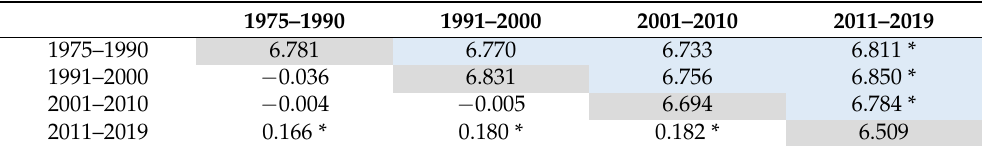
Table 3. Average pairwise differences between each generation interval period in the total population (related and unrelated horses). Above the diagonal (blue): average number of pairwise differences between populations ( π XY); Diagonal elements (gray): average number of pairwise differences within the population ( π X); Below diagonal (white): corrected average pairwise difference ( π XY − ( π X + π Y). * = significant difference between the groups ( p < 0.05).